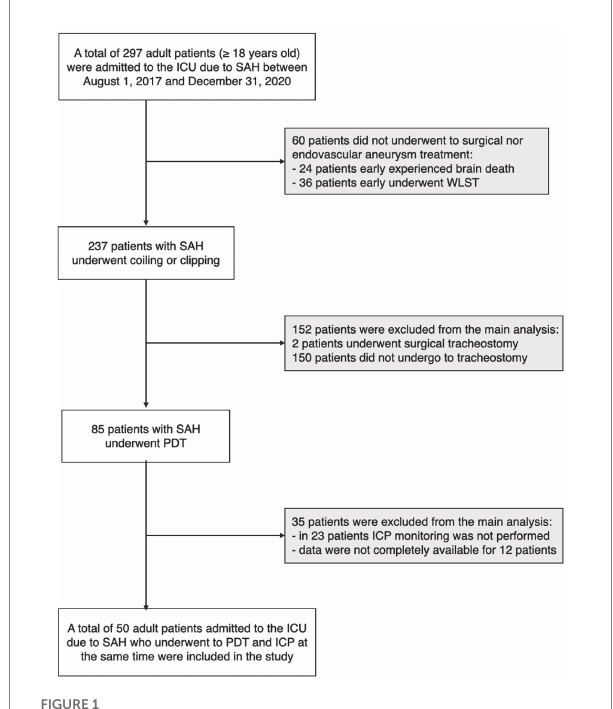
FIGURE 1 Flow chart of study population selection; in the gray boxes, the subjects were excluded from the main analysis (see methods). ICU, intensive care unit; SAH, subarachnoid hemorrhage; WLST, withdrawal of life-sustaining treatments; PDT, percutaneous dilational tracheostomy; ICP, intracranial